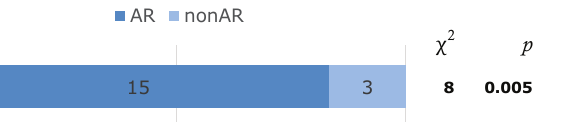
Figure 5. Frequencies of user preferences for two compared visualization modes AR and non-AR. Right side shows the results of Chi-square analysis. The results indicate that the measured preference of AR is statistically